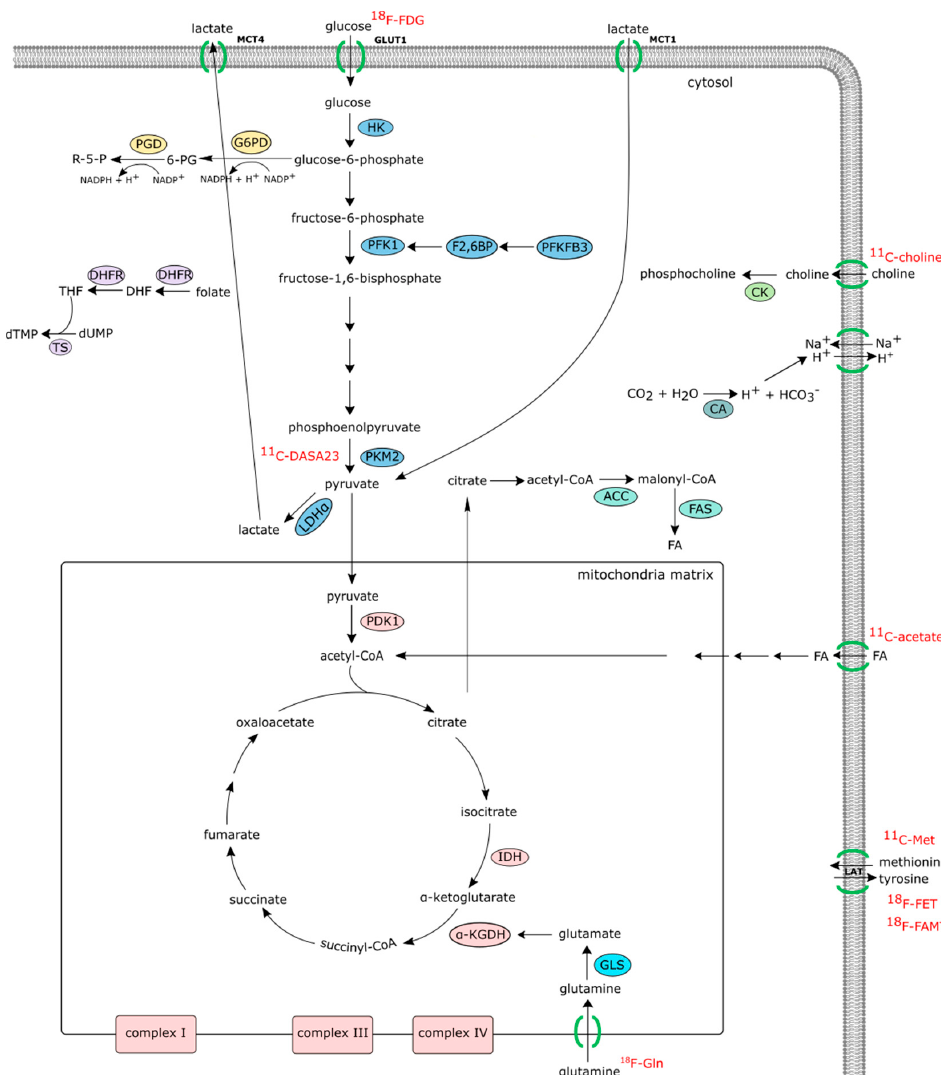
Figure 1. Positron emission tomography (PET) methods that provide information on the underlying biochemical processes. PET imaging not only can improve clinical diagnostics but also potentially predict treatment effects. 18 F-FDG, 2-deoxy-2-(fluorine-18)fluoro-D-glucose, provides information on glycolysis and glucose uptake; 11 C-DASA23, a class of N, N-diarylsulfonamides, is able to measure PKM2 uptake; 18 F-Gln, 18 F-(2 S ,4 R )4-fluoroglutamine, allows for the monitoring of glutamine metabolism. 11 C-Met, 11 C-methionine; 18 F-FET, O-(2-[ 18 F]fluoroethyl)-L-tyrosine; 18 F-FAMT, L-3-(18F)-Fluoro- α -methyl tyrosine; radiolabeled methionine and tyrosine can provide data on amino acid uptake and protein synthesis. Finally, 11 C-acetate is converted to acetyl-CoA and used in mitochondria in TCA cycle or incorporated into cell membranes. MCT4, monocarboxylate transporter 4; GLUT1, glucose transporter 1; MCT1, monocarboxylate transporter 1; R-5-P, ribose-5-phosphate; PGD, phosphogluconate dehydrogenase; 6-PG, 6-phosphogluconate; G6PD, glucose-6-phosphate-dehydrogenase; HK, hexokinase; PFK1, phosphofructokinase 1; F2,6BP, fructose-2,6-bisphosphate; PFKFB3, 6-phosphofructo-2-kinase/fructose-2,6-bisphosphatase 3; dTMP, deoxythymidine monophosphate; dUMP, deoxyuridine monophosphate; TS, thymidylate synthase; THF, tetrahydrofolate; DHF, dihydrofolate; DHFR, dihydrofolate reductase; CK, choline kinase; PKM2, pyruvate kinase muscle isozyme M2; LDH α , lactate dehydrogenase A; CA, carbonic anhydrase; ACC, acetyl-CoA carboxylase; FAS, fatty acid synthase; PDK1, pyruvate dehydrogenase kinase 1; IDH, isocitrate dehydrogenase; α -KGDH, alpha-ketoglutarate dehydrogenase; GLS, glutaminase.